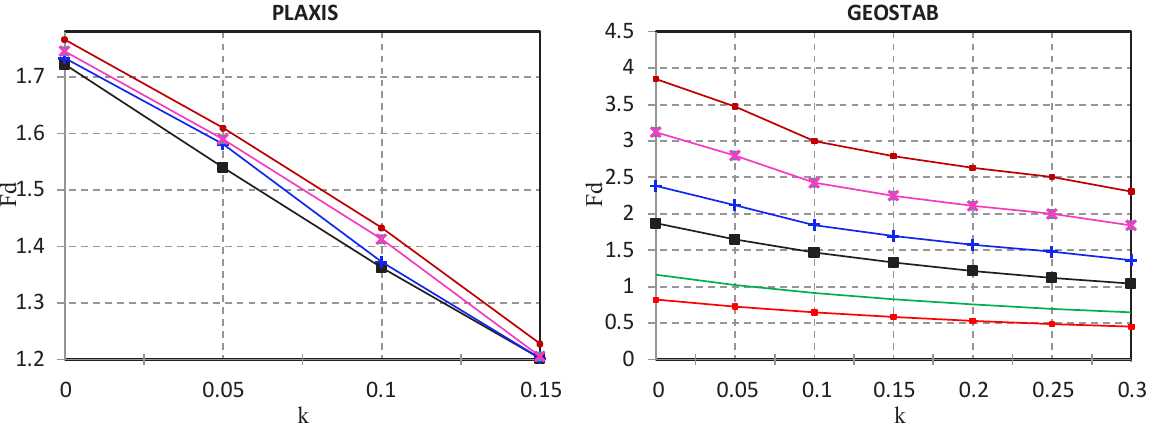
Figure 8: Effect of the core cohesion with PLAXIS and GEOSTAB.